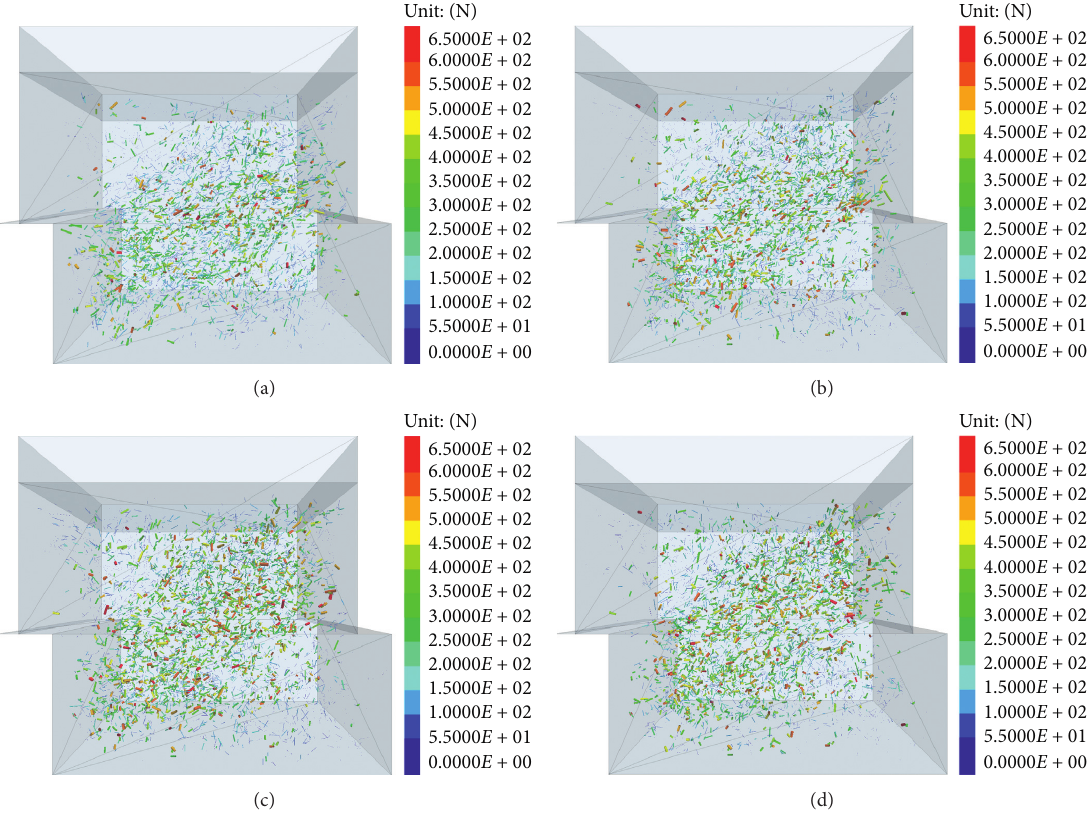
Figure 6: The contacts between ballast particles at ε